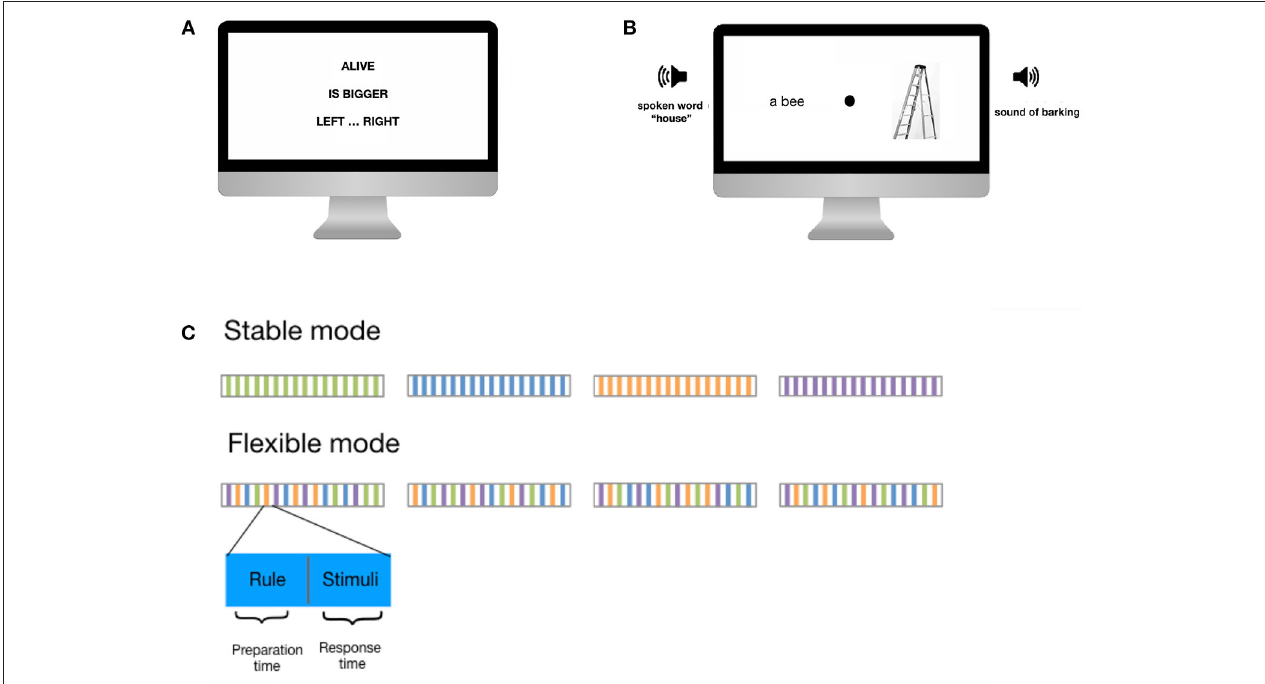
FIGURE 1 | Example trial of the C3T. (A) First a three-element rule is presented. (B) After pressing a button, a set of visual and auditory stimuli is presented to which the participant must respond. In the example shown, the participants had to focus on those stimuli relating to living creatures (in this case a bee and a dog), compare which of the two is larger, and press the left button if the larger animal was presented on the left, or the right button if the larger animal was presented on the right. Since a dog is bigger than a bee and the barking of the dog was presented on the right side, the correct answer was to press the right button. (C) Time course of the task in stable and flexible mode. Preparation time is the time from the presentation of the rule until the button is pressed to have the stimuli presented. Response time is the time from the presentation of the stimuli to the response.